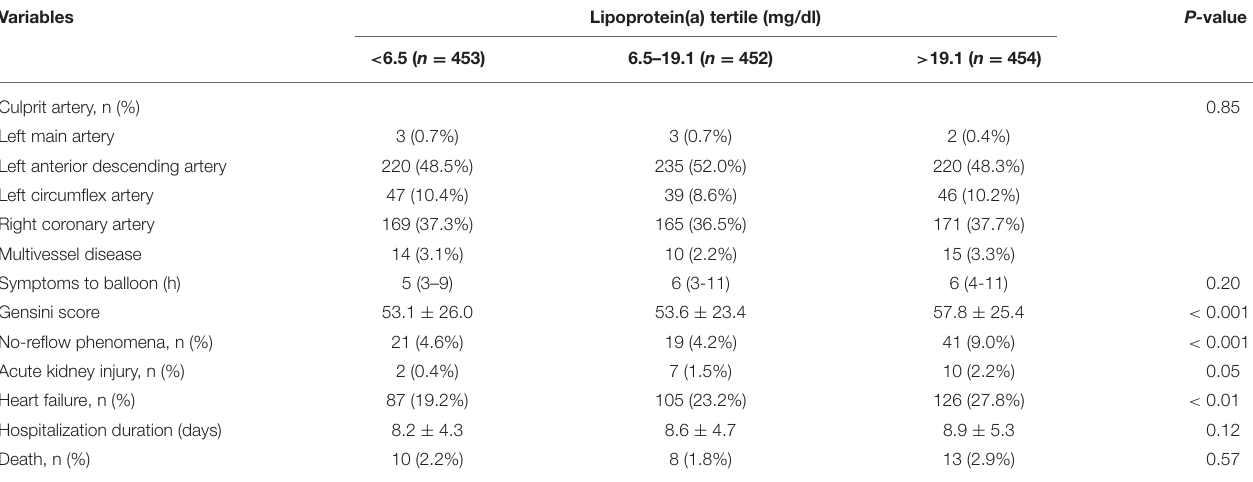
TABLE 2 | Angiographic characteristics and clinical outcomes during hospitalization by tertiles of lipoprotein(a) level.